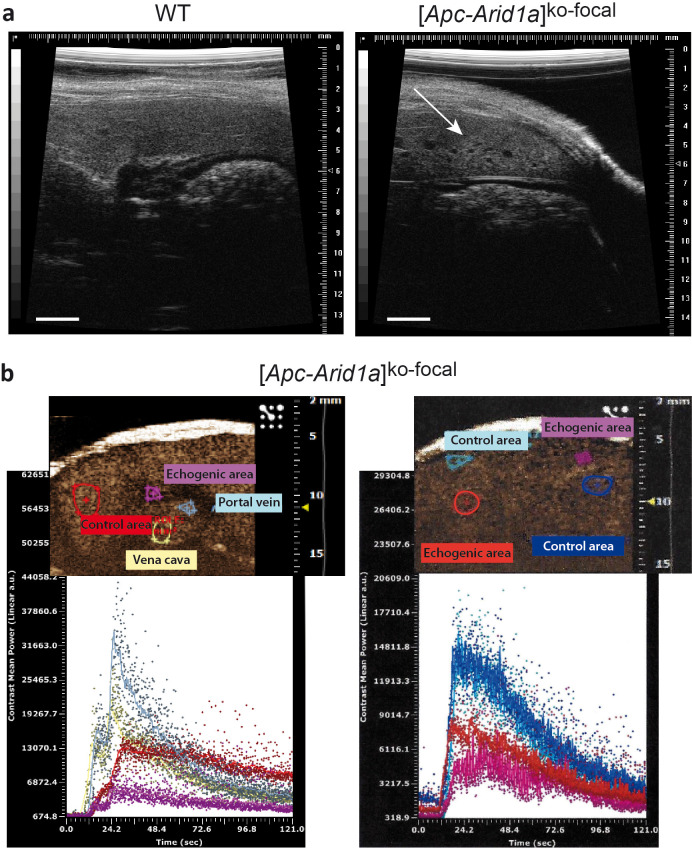
Ultrasound features of livers from seven-month-old [Apc-Arid1a]ko-focal mice.(a) Echogenicity of peliotic areas within the [Apc-Arid1a]ko-focal liver (arrow), showing striking tissue modification. Scale bars = 2 cm. (b) Dynamic contrast-enhanced ultrasound using microbubble administration. Contrast-enhanced ultrasound imaging involves the injection of gas-filled micron-sized bubbles (microbubbles) that do not extravasate. This property makes them ideal contrast agents for imaging vascularity and blood perfusion. The protocol has been described in Snipstad et al., 2017. It revealed a decrease of hepatic vascular perfusion within echogenic areas compared to neighboring control tissue.